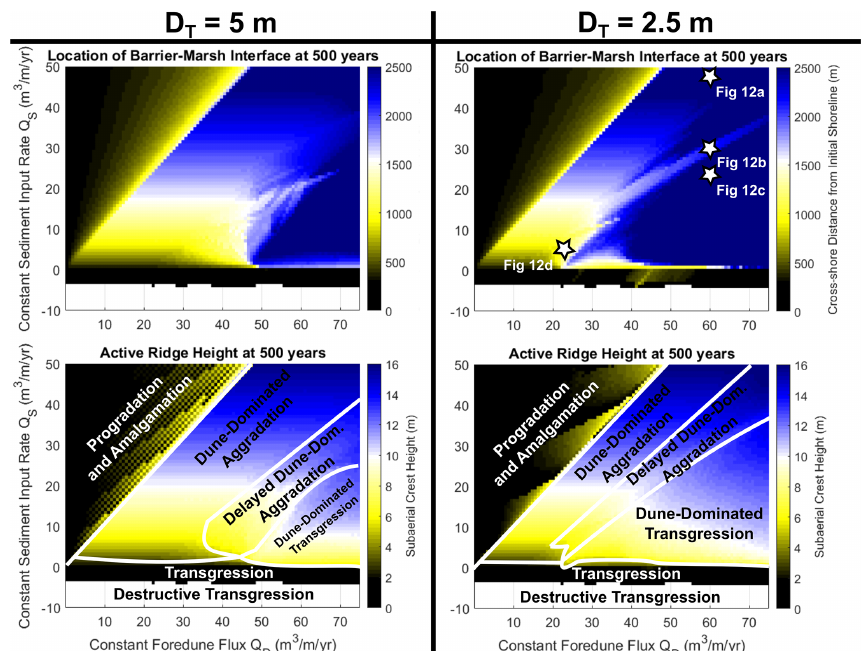
Figure 11. Plots of barrier–marsh interface location x b and active foredune crest height H for a 500-year simulation of a modeled barrier with input parameters described by Table 3 where D T = 5 and 2.5m. Regions with no data (destructive transgression) correspond with complete dune loss and potential barrier disintegration. D T is the thickness of the barrier substructure, or the depth of the active shoreface over decadal timescales. Q S represents shoreface